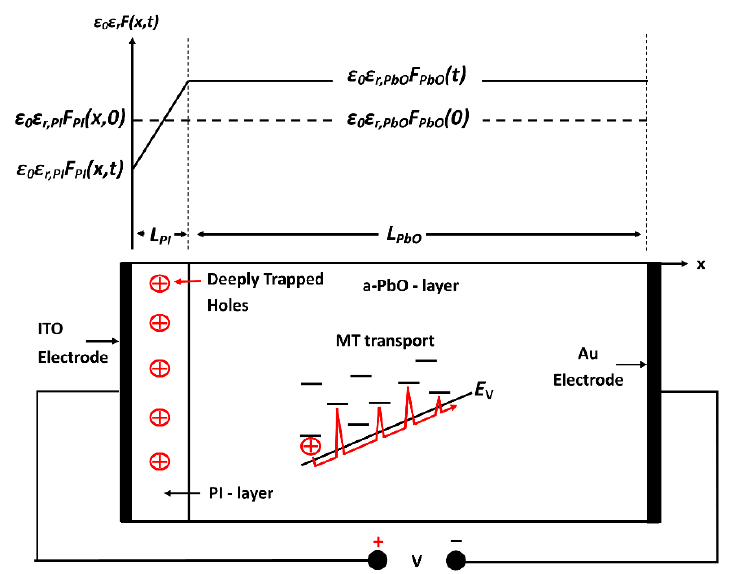
Figure 6. A simplified schematic diagram of the PI/a-PbO detector and its time-dependent spatial electric displacement field profile. The dashed line represents the displacement field at the instant of bias application. The solid line represents the displacement field profile post-bias application when holes have accumulated in PI. In addition, a schematic of MT transport of thermally generated holes through the bulk of a-PbO is illustrated.